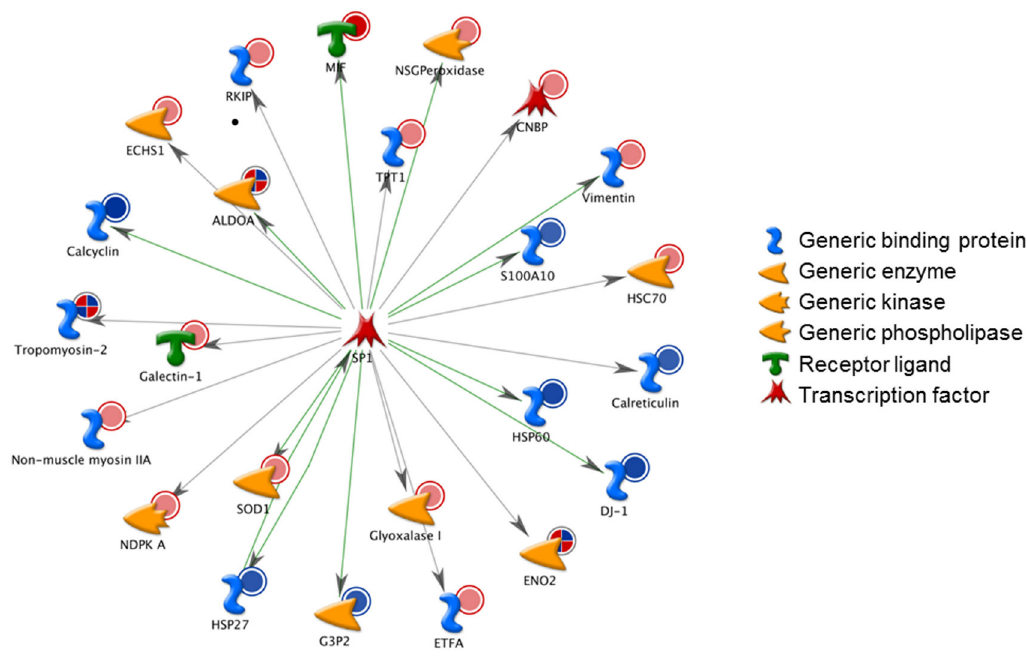
Figure 3. Network analysis of differentially expressed proteins. The top score transcription regulation network initiated through activation of SP1 is shown. Network proteins are visualized by proper symbols, which specify the functional nature of the protein (network caption). Green and gray arrows indicate positive and unspecified effects, respectively. Red and blue circles indicate up- and down-regulated proteins following SF treatment, respectively. ‘Checkerboard’ color indicates mixed expression between files. doi: